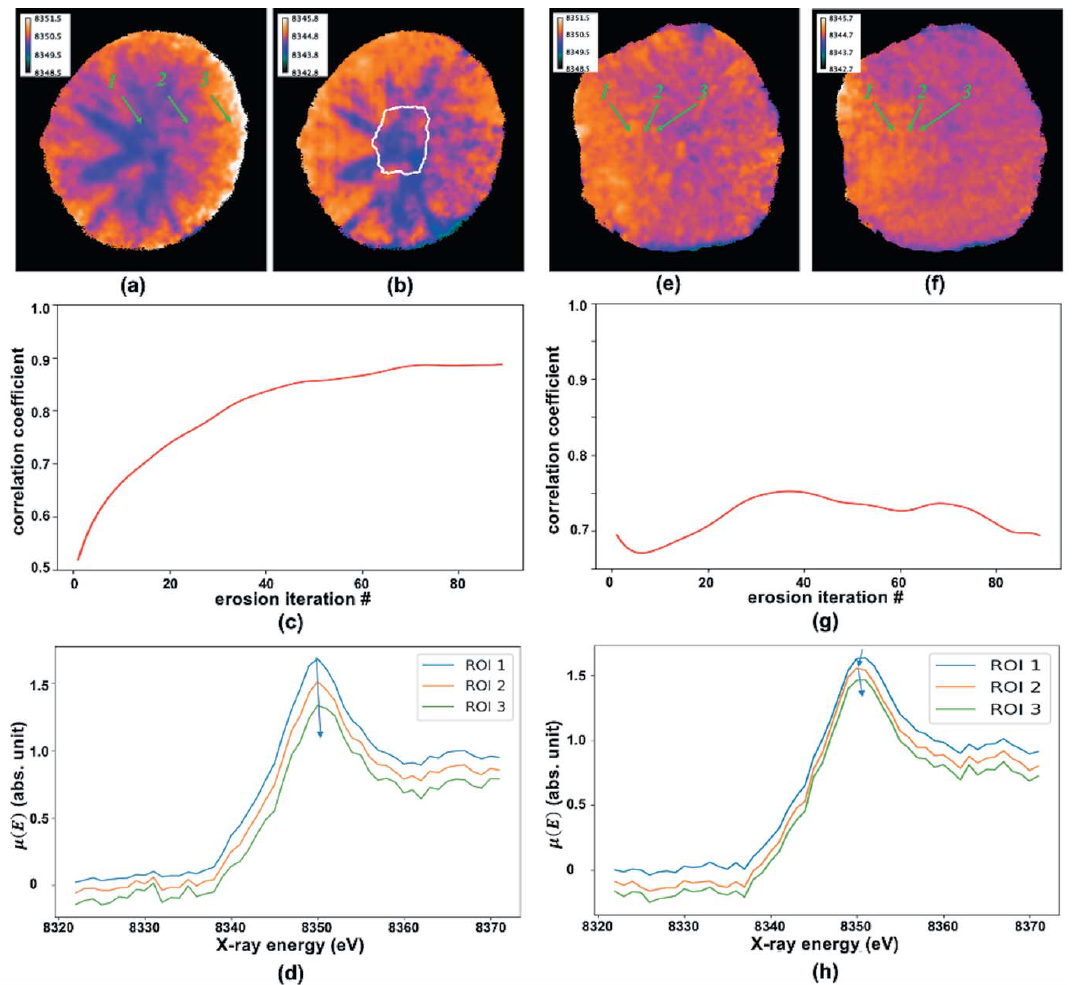
Figure 6 Comparison between analysis results with white-line and edge-50 methods. ( a ) White-line and ( b ) edge-50 maps of a NMC811 particle; the correlation between ( a ) and ( b ) as a function of ROI with the size shrinking from the outline of the particle to that marked in ( b ) is shown in ( c ). ( d ) Spectra of three ROIs indicated in ( a ). The white-line peak position shifts toward higher energy when the ROI moves from the inner region to the outer region, and the corresponding edge-50 positions show the same trend. ( e )–( h ) Results of a second NMC811 particle. Although the white-line position of ROI 2 is lower than ROIs 1 and 3, its edge-50 position is highest in three ROIs (ROI 1: 8344.8 eV; ROI 2: 8344.8 eV; ROI 3: 8345.7